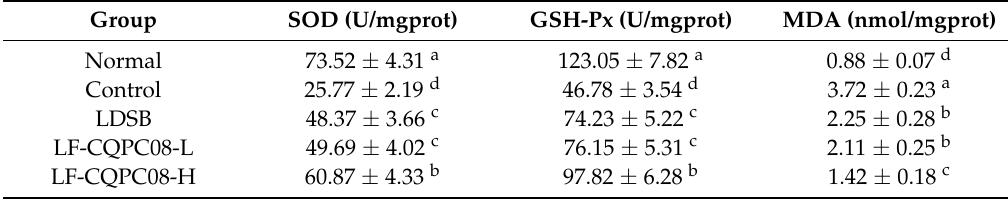
Table 6. Tongue tissue levels of SOD, GSH-Px and MDA in mice.